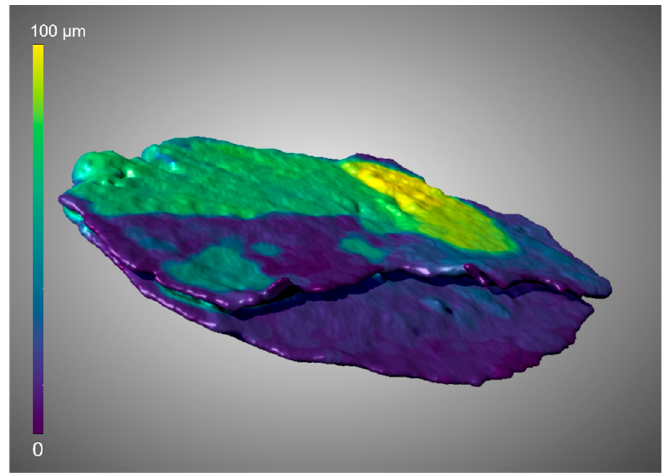
Figure 10. Jumbo flake after thickness measurement. The ESD of the flake is 421 µm. Table 6. Selected textural properties of an individual graphite flake.